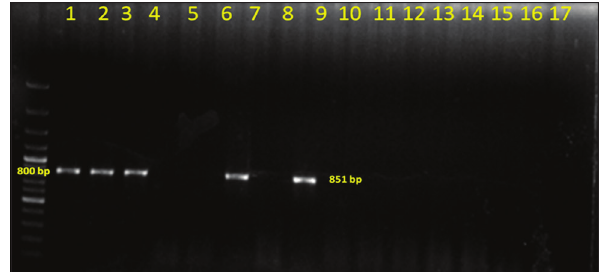
Figure-2: Gel electrophoresis image of polymerase chain reaction amplified products of bla gene of Gram- TEM negative isolates; Lane 1 - 1500 bp DNA ladder; Lane 2-8, 10-16 - Isolated Escherichia coli samples; Lane 15 - Positive control for bla gene; Lane 20 - Negative TEM